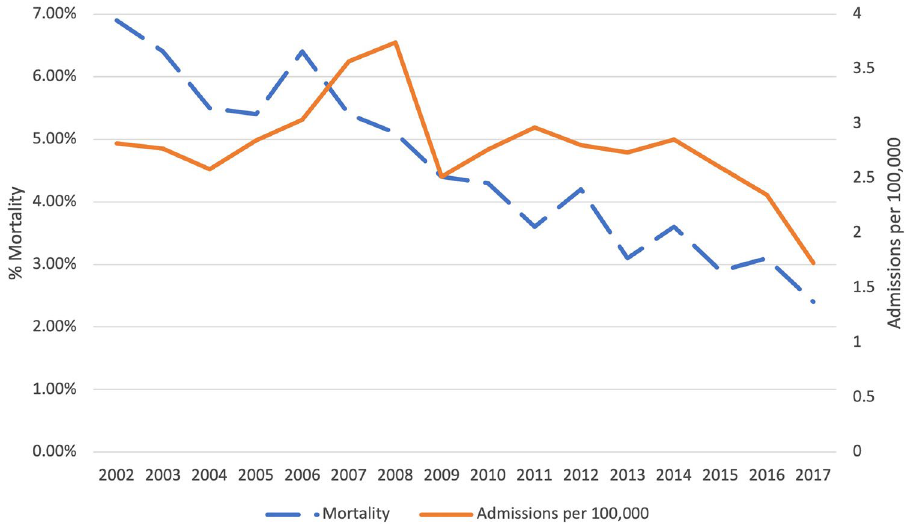
Fig. 1 Trends in inpatient mor- tality and admission rates over time for acute myeloid leukemia in the United States